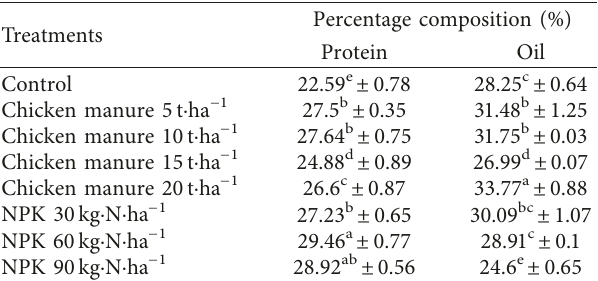
Table 9: Effect of different rates of chicken manure and NPK fertilizers on percentage crude protein and oil contents of sun- flower seeds.